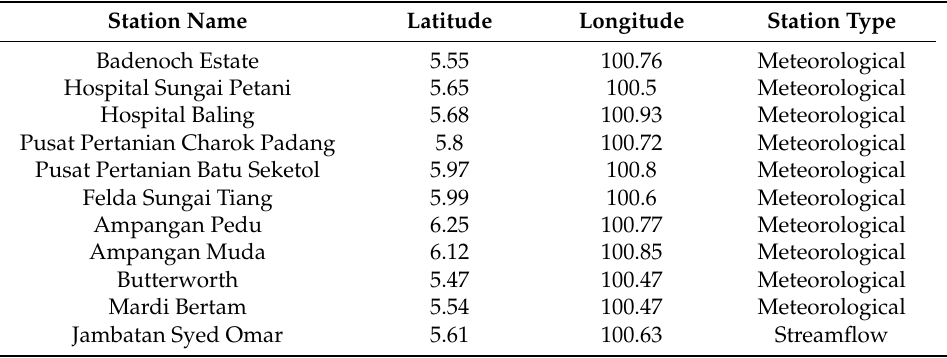
Table 2. List of meteorological and streamflow